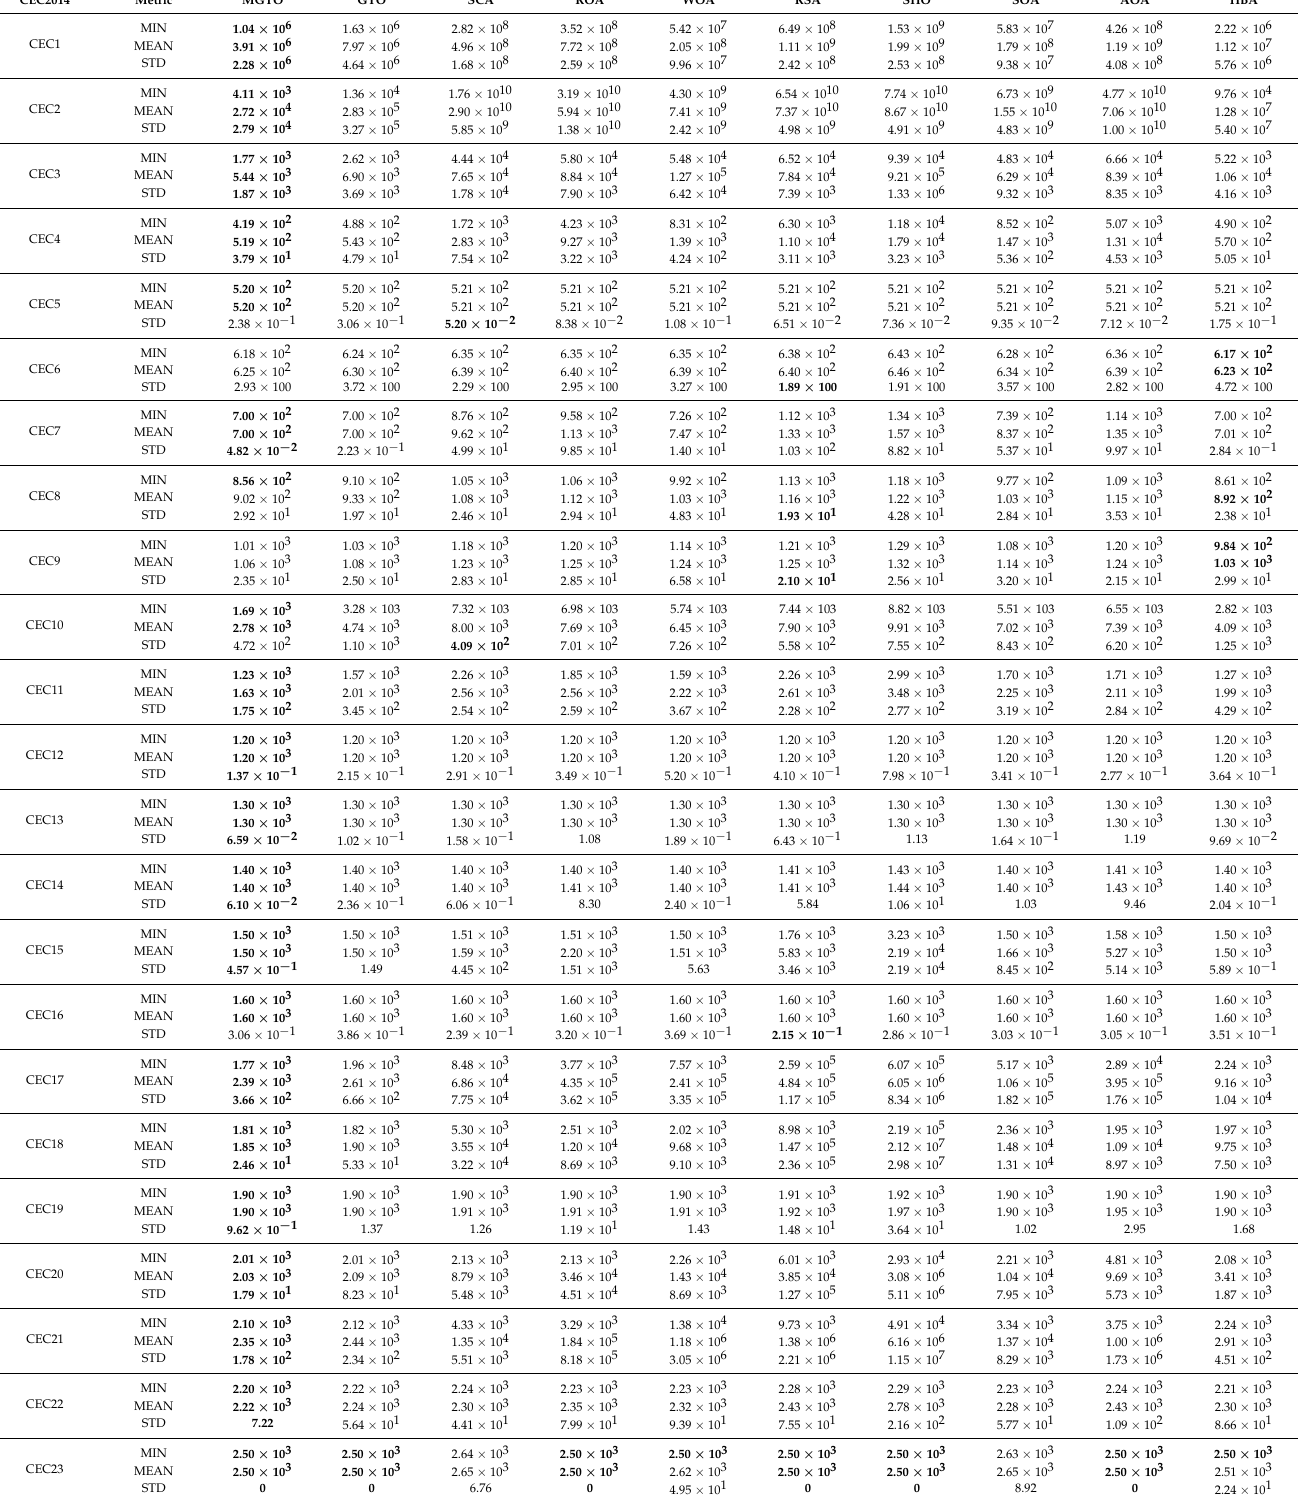
Table 5. CEC2014 Algorithm Results of Benchmark